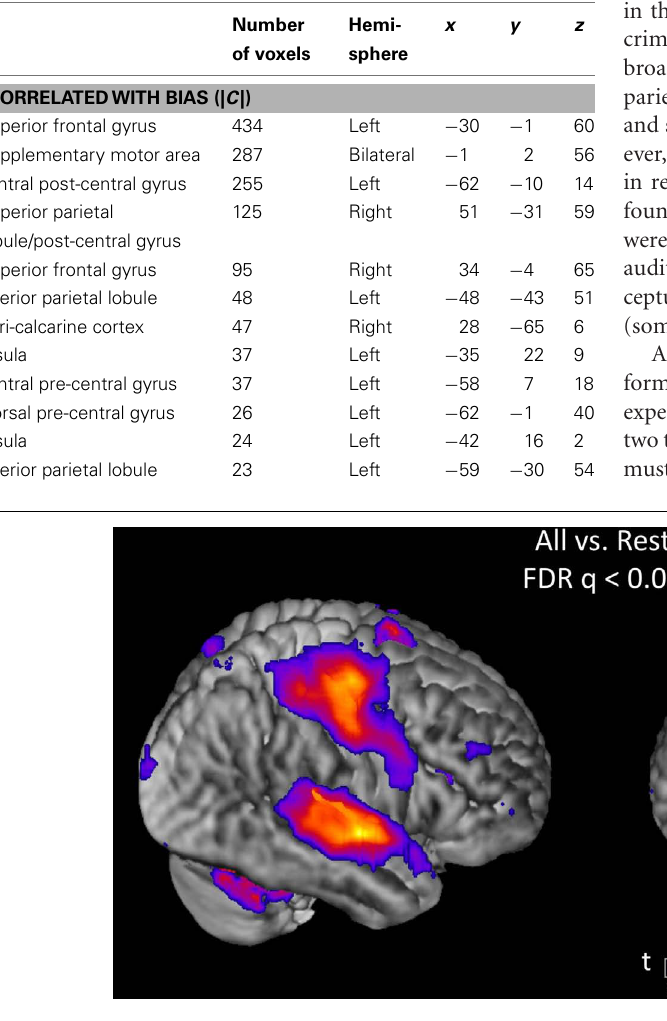
FIGURE 4 | Group ( n = 15) t -map for the contrast corresponding to mean activation in the syllable discrimination task (versus rest) across all five bias ratio conditions. The statistical image was thresholded at FDR-corrected q < 0.05.The set of voxels identified in this contrast were used as a mask for all subsequent